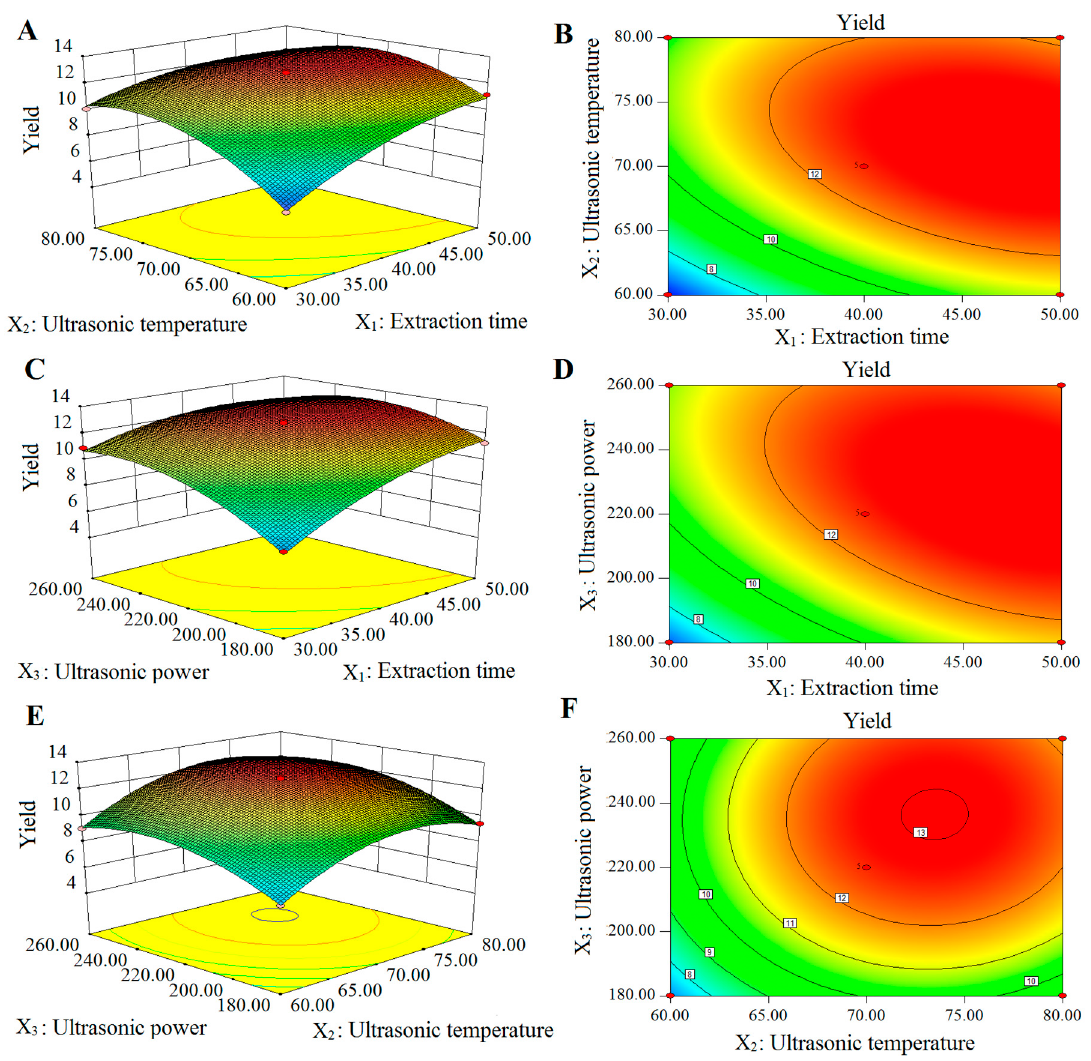
Figure 3. The 3D response surface and 2D contour plots showing the effects of extraction factors on the yield of PSA. ( A , B ) were 3D response surface and 2D contour plots showing the effects of extraction time and ultrasonic temperature on the yield of PSA; ( C , D ) were 3D response surface and 2D contour plots showing the effects of extraction time and ultrasonic power on the yield of PSA; ( E , F ) were 3D response surface and 2D contour plots showing the effects of ultrasonic temperature and ultrasonic power on the yield of PSA.